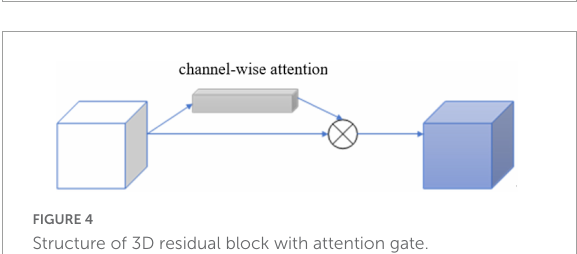
FIGURE3 The architecture of our proposed 3D convolutional neural network (CNN).